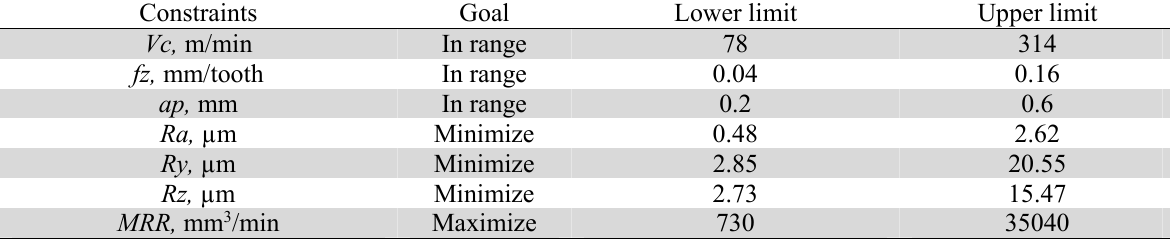
Constraints for optimization of machining parameters